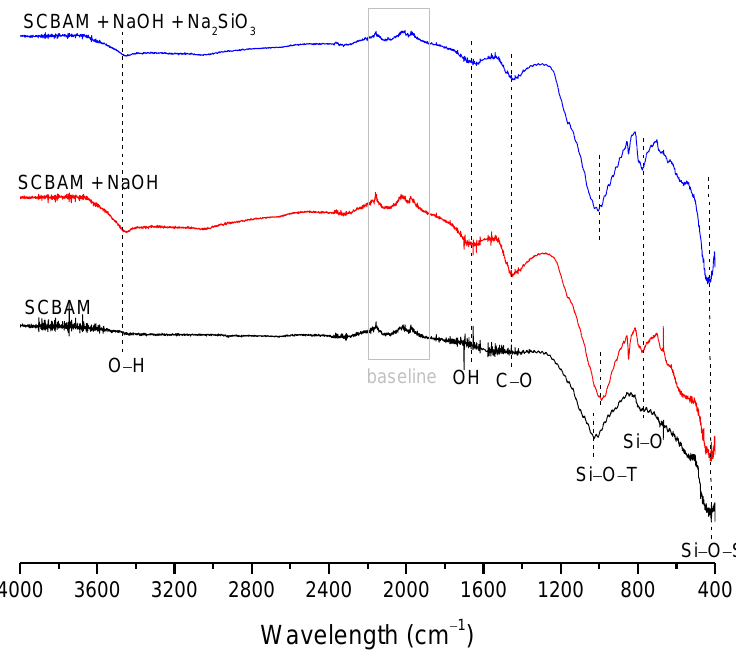
Figure 9. SCBAM and SCBAM activated pastes.